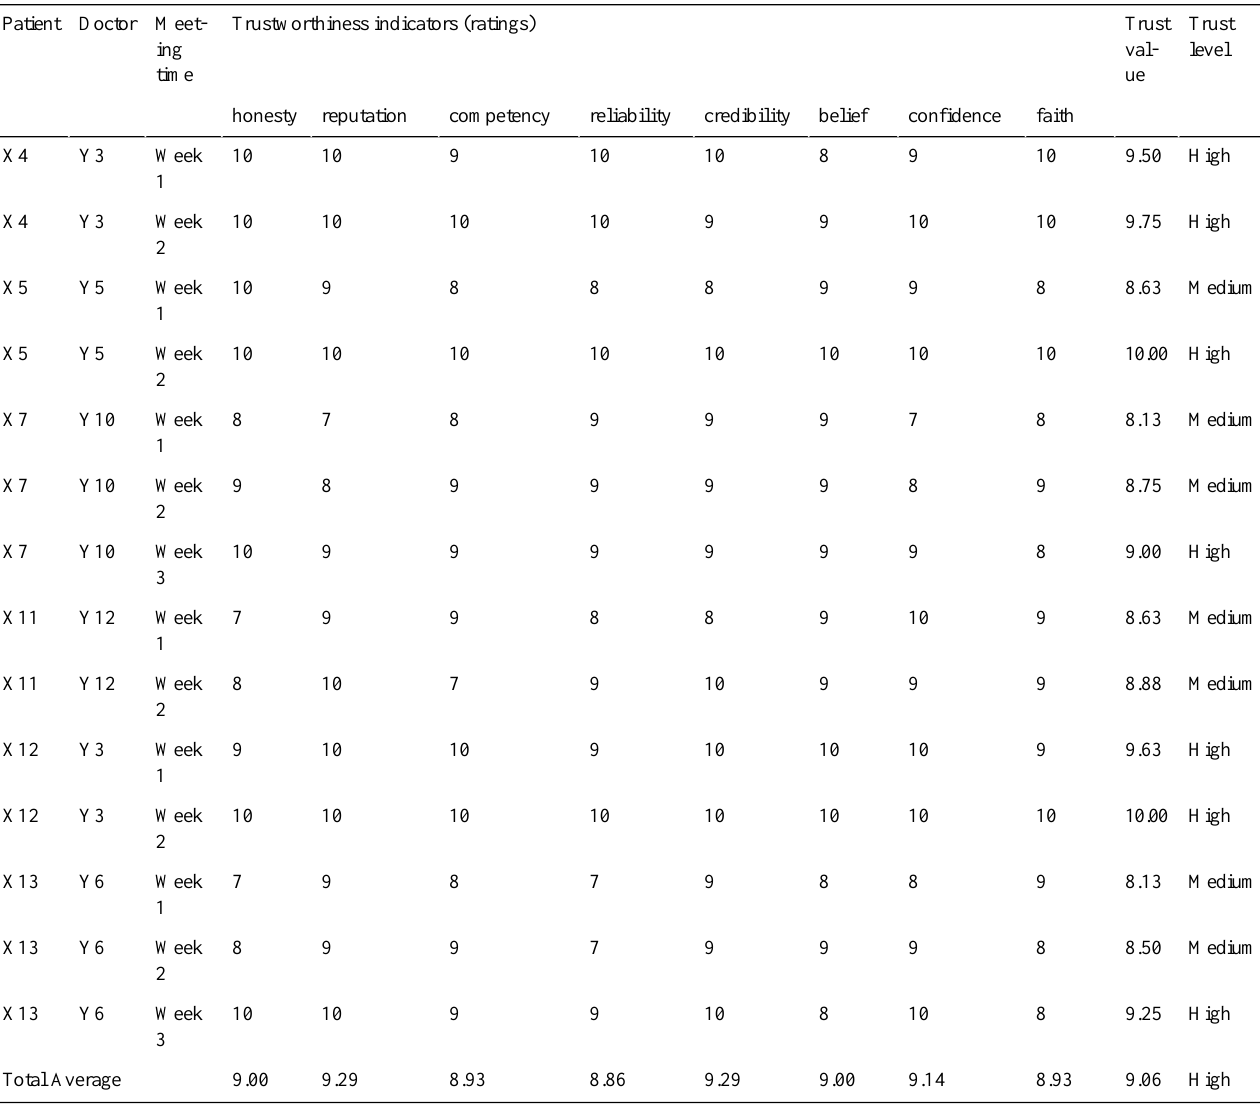
Table 6. Interaction between a patient and a doctor over different time